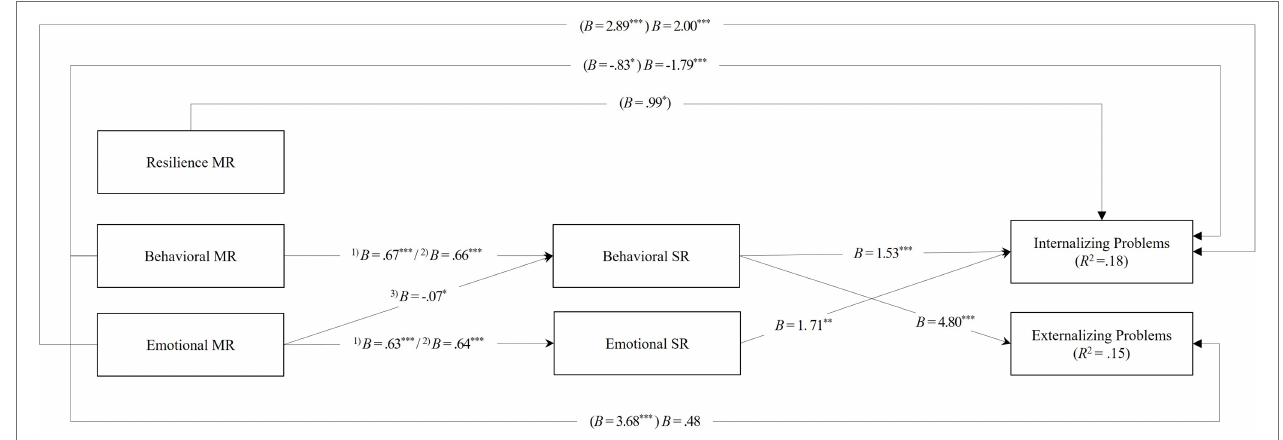
FIGURE 2 | Model examining the associations between youth’s meta-representations (MR) and their mental health (i.e., internalizing and externalizing problems) mediated by their self-representations (SR). Coefficients in brackets refer to the total effects of MR domains on internalizing and externalizing problems. 1) Estimate obtained in the model for internalizing problems. 2) Estimate obtained in the model for externalizing problems. 3) Estimate obtained in both models. * p < 0.05, ** p < 0.01, and *** p < 0.001.